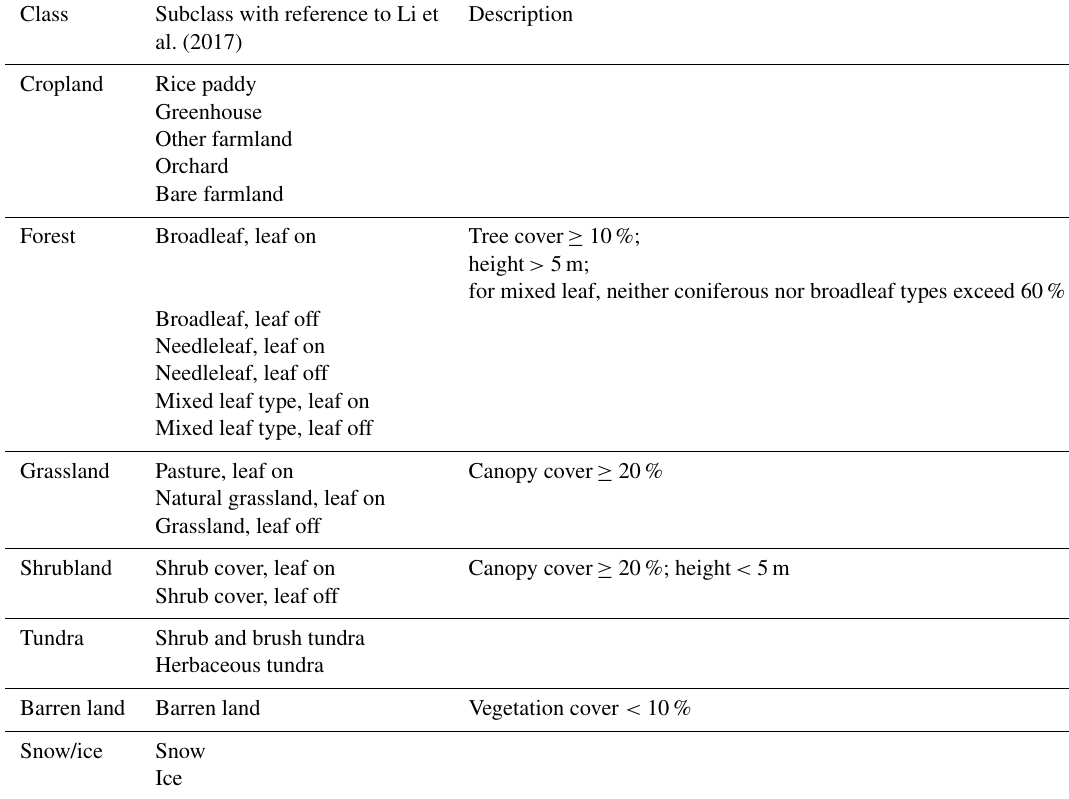
Table 1. Classification system, with seven land cover classes. Class Subclass with reference to Li et al. (2017)